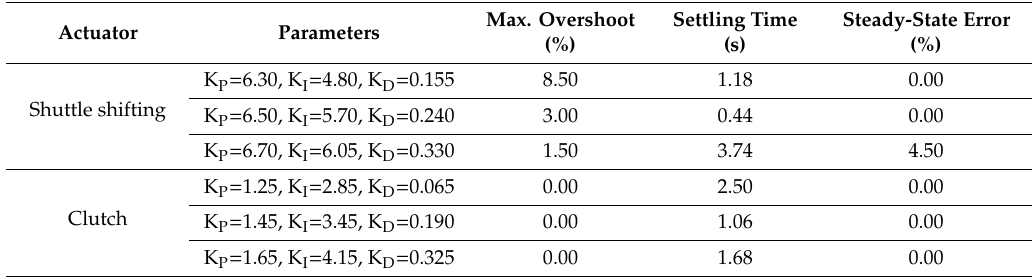
Figure 10. Comparison result of position control of ( a ) shuttle shifting actuator and ( b ) clutch actuator according to PID coe ffi cients. Table 2. Response performance of shuttle shifting actuator and clutch actuator according to PID coe ffi